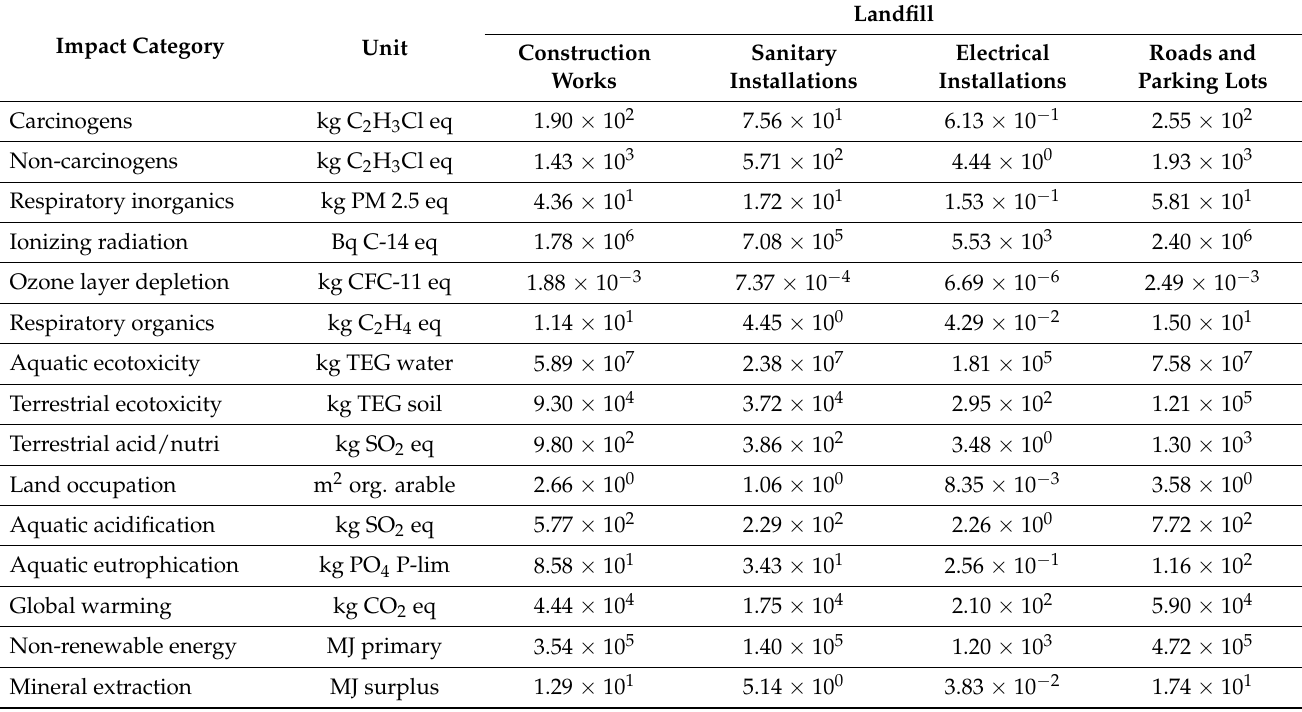
Table 6. The results of characterizing the environmental consequences occurring at the post-use development stage (in the form of storage) of the research object by the groups of installations.